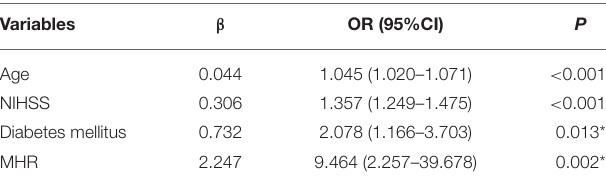
TABLE 2 | Multivariate logistic regression model a of predictors to 3-month poor